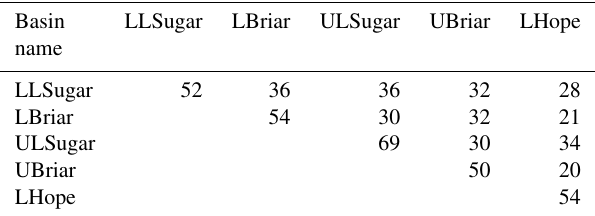
Table 2. Overlap in top flood producing storms for the five basins in Little Sugar Creek catchment, absolute numbers of